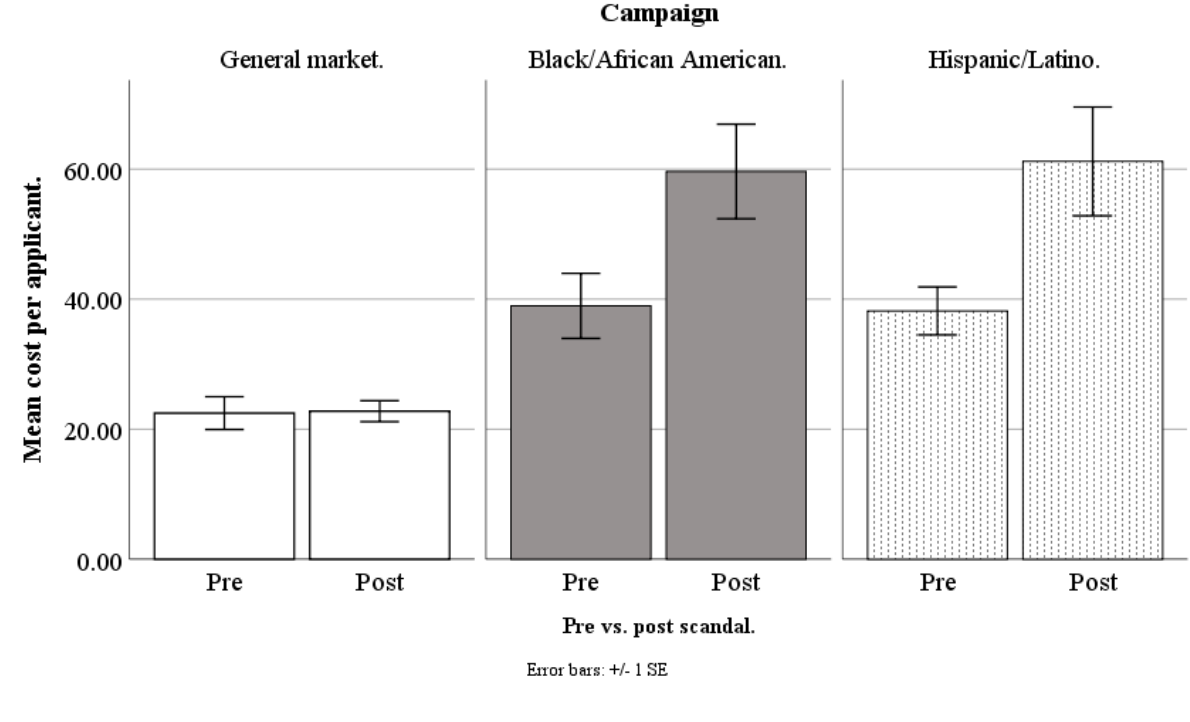
Figure 17. Mean costs per participant for Facebook advertising campaigns before versus after privacy